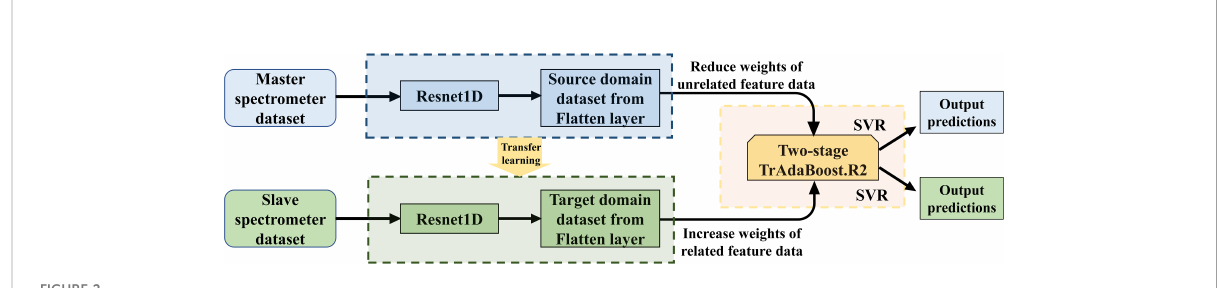
FIGURE 2 Schematic diagram of